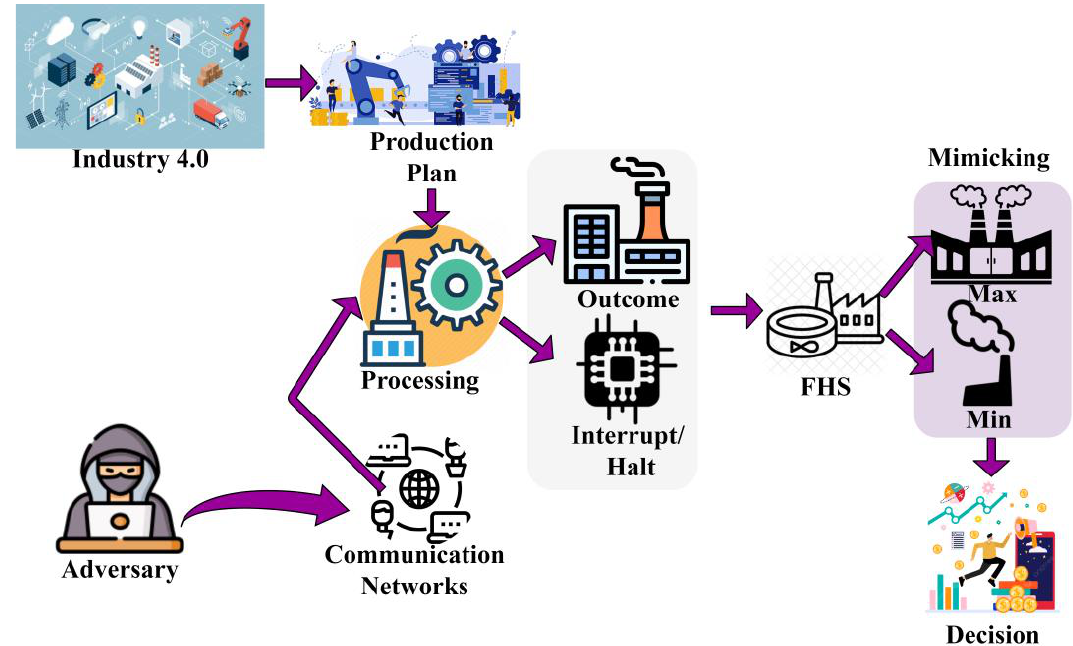
Figure 1. Proposed Technique Illustration.